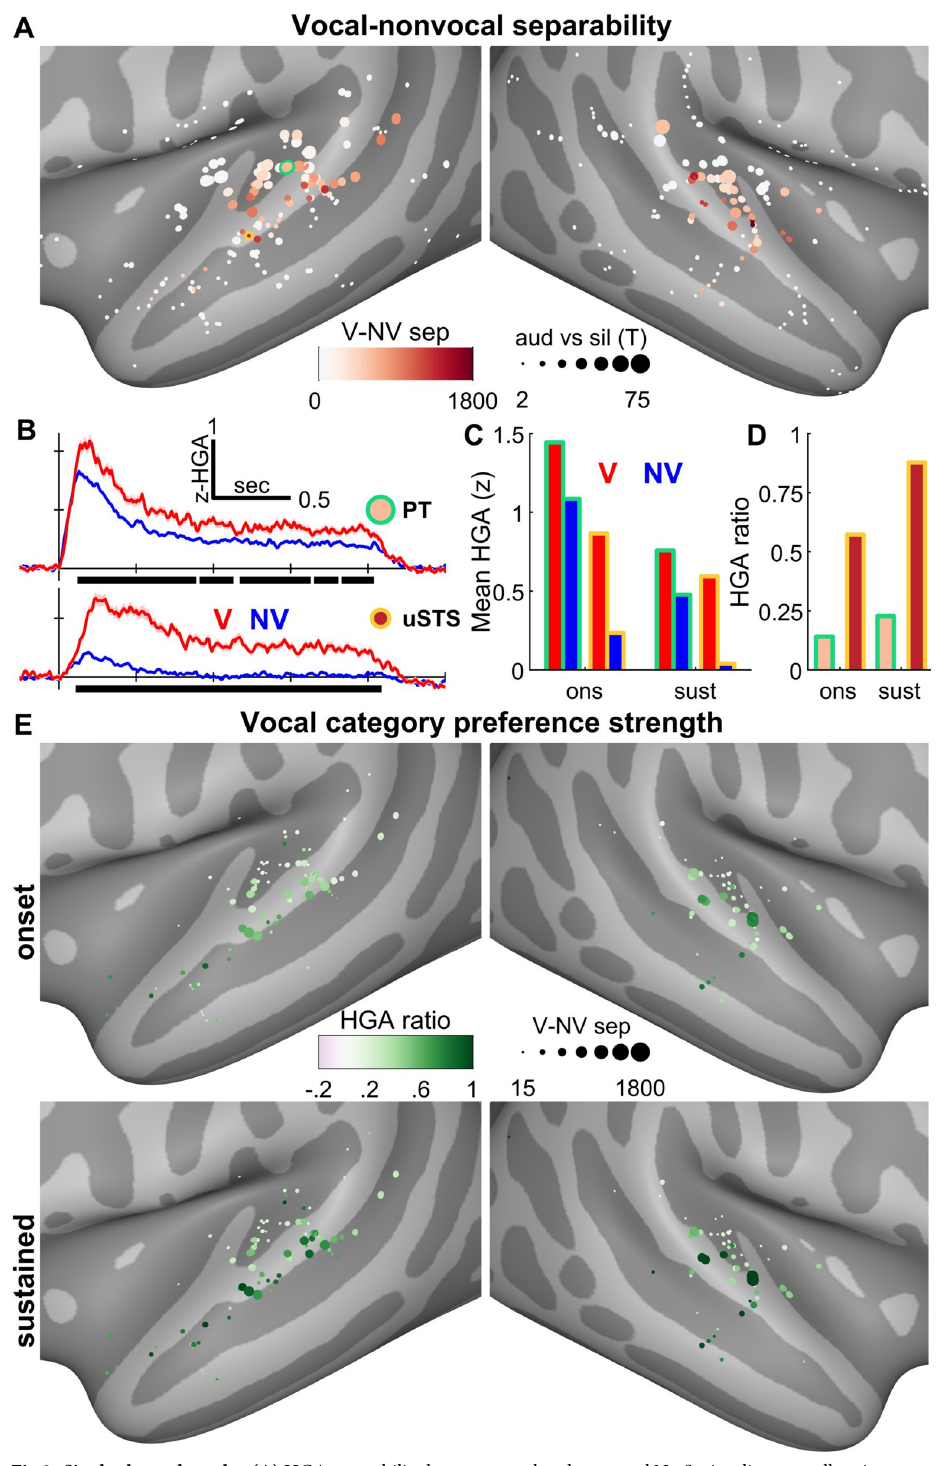
Fig 3. Single channel results. (A) HGA separability between vocal and nonvocal NatS stimuli, across all patients. Channel sizes are proportional to t-statistics comparing auditory response magnitude between 500 ms pre- and poststimulus onset windows, same as Fig 1D. (B) HGA for 2 example channels located in PT (upper panel) and uSTS (lower panel). Black bars show clusters of significantly different timepoints; V–NV separability (panels A, E) is the sum of all clusters for a given channel. Note that while both channels achieve V–NV separability throughout the duration